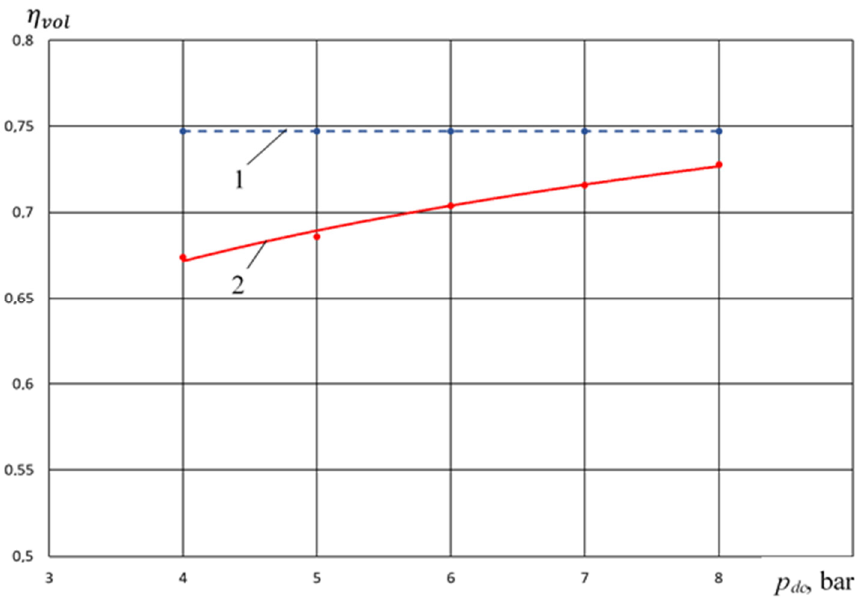
Figure 16. Volumetric efficiency the pump section from the discharge pressure of the compressor section (1—Theory; 2—Experiment).